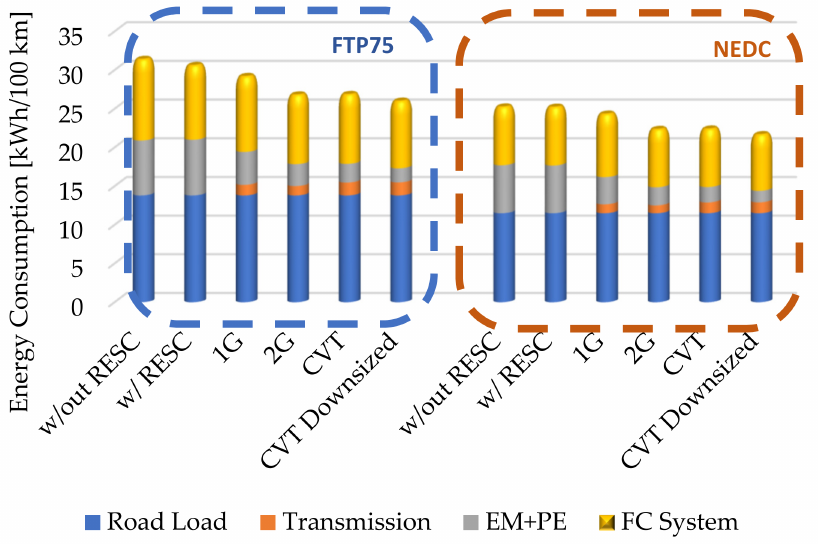
Figure 13. Comparison of energy recovery: ( a ) FTP75 drive cycle; ( b ) NEDC drive cycle.